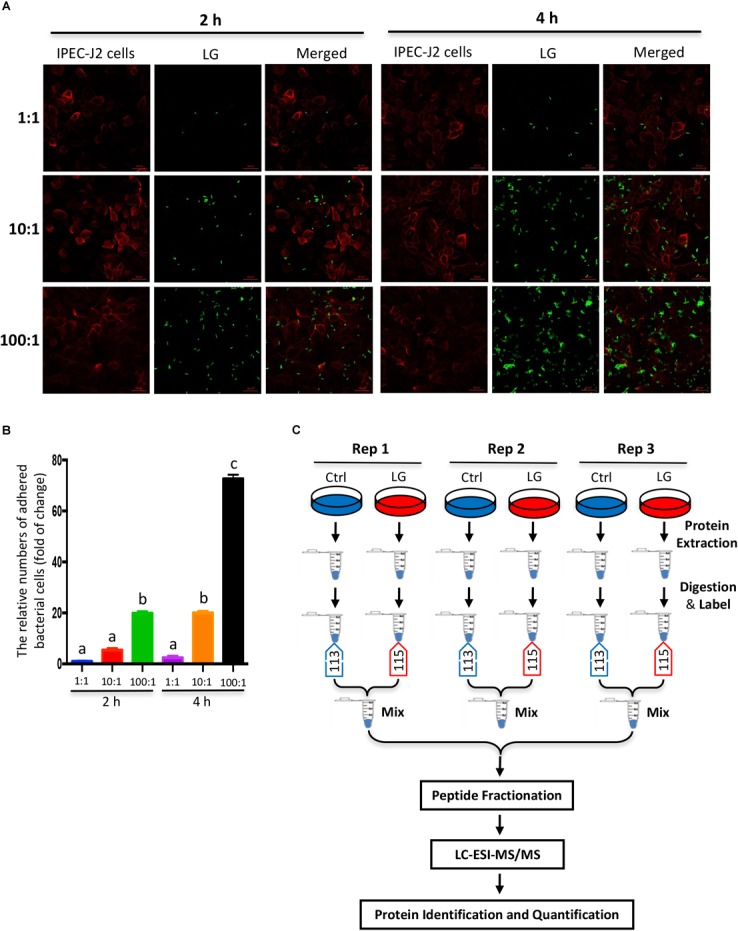
Experimental design and schematic workflow for iTRAQ assay. (A)
In vitro assay of bacterial adhesion to IPEC-J2 cells was shown by fluorescence staining. FITC-labeled L. gasseri LA39 (green) were added into IPEC-J2 cell medium for 2 or 4 h and the initial ratios of L. gasseri LA39 numbers to IPEC-J2 cell numbers were 1:1, 10:1, or 100:1. The plasma membranes of IPEC-J2 cells were labeled by wheat germ agglutinin (WGA) dye (red). (B) The relative numbers of adhered bacterial cells to IPEC-J2 cells. Data are represented as mean ± SEM (n = 3). Different letters above the bars denotes a significant difference among the groups. (C) Schematic workflow for the iTRAQ assay as described in Materials and Methods.